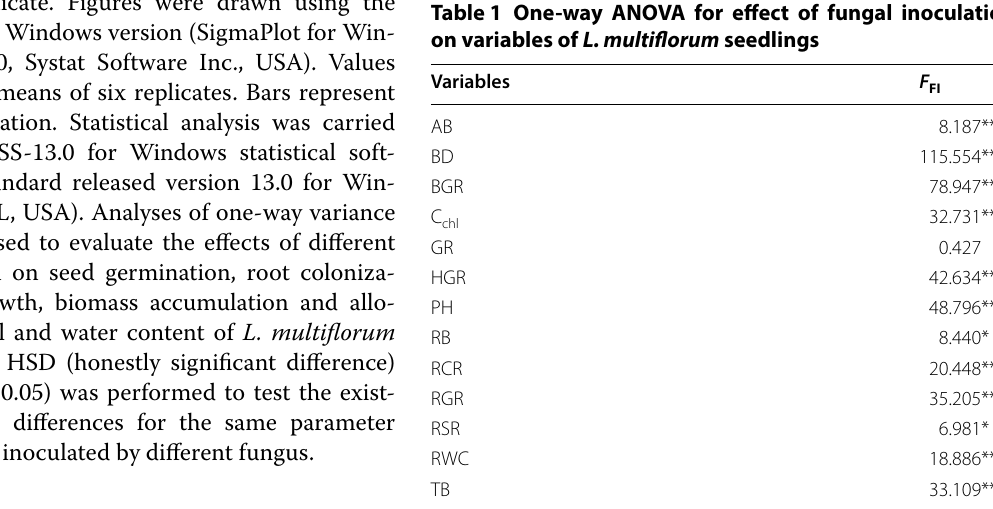
AB, above-ground biomass; BD, basal diameter; BGR, relative basal diameter growth rate; C chl , leaf chlorophyll content; GR, germination rate; HGR, relative height growth rate; PH, plant height; RB, root biomass; RCR, root colonization rate; RGR, relative growth rate; RSR, the root/shoot ratio; RWC, leaf relative water content; TB, total biomass; F FI , effect of fungi inoculation * , ** , *** , Significant at P 0.05, 0.01, and 0.001, ≤